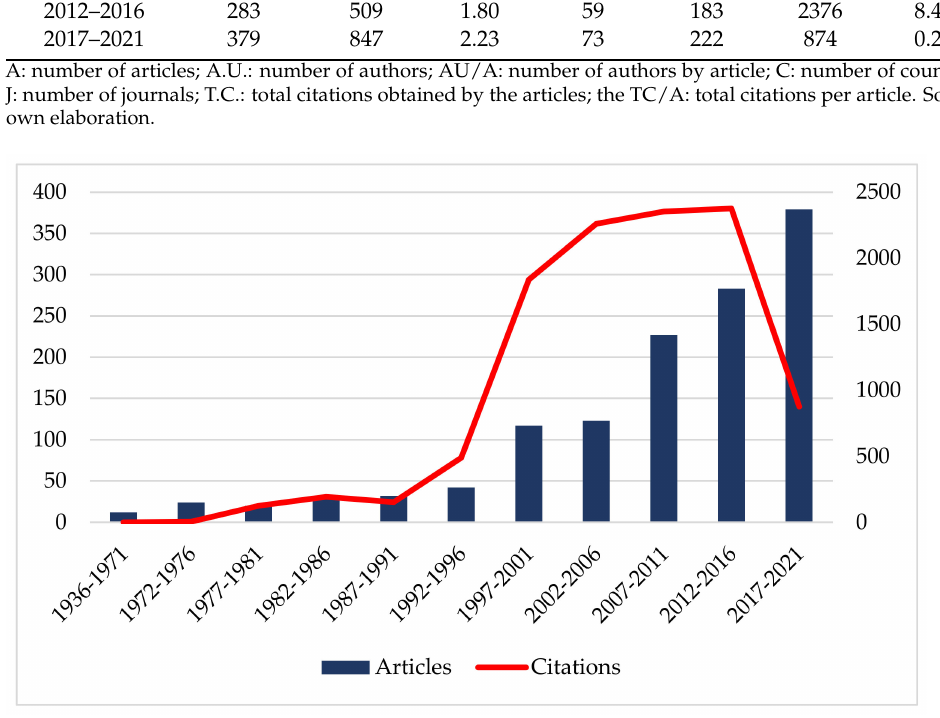
Figure 2. Evolution over time of the published articles in each period on pension research and the total number of citations they have obtained. The left axis represents the number of published articles, and the right axis the number of citations received by the published articles. Source: own